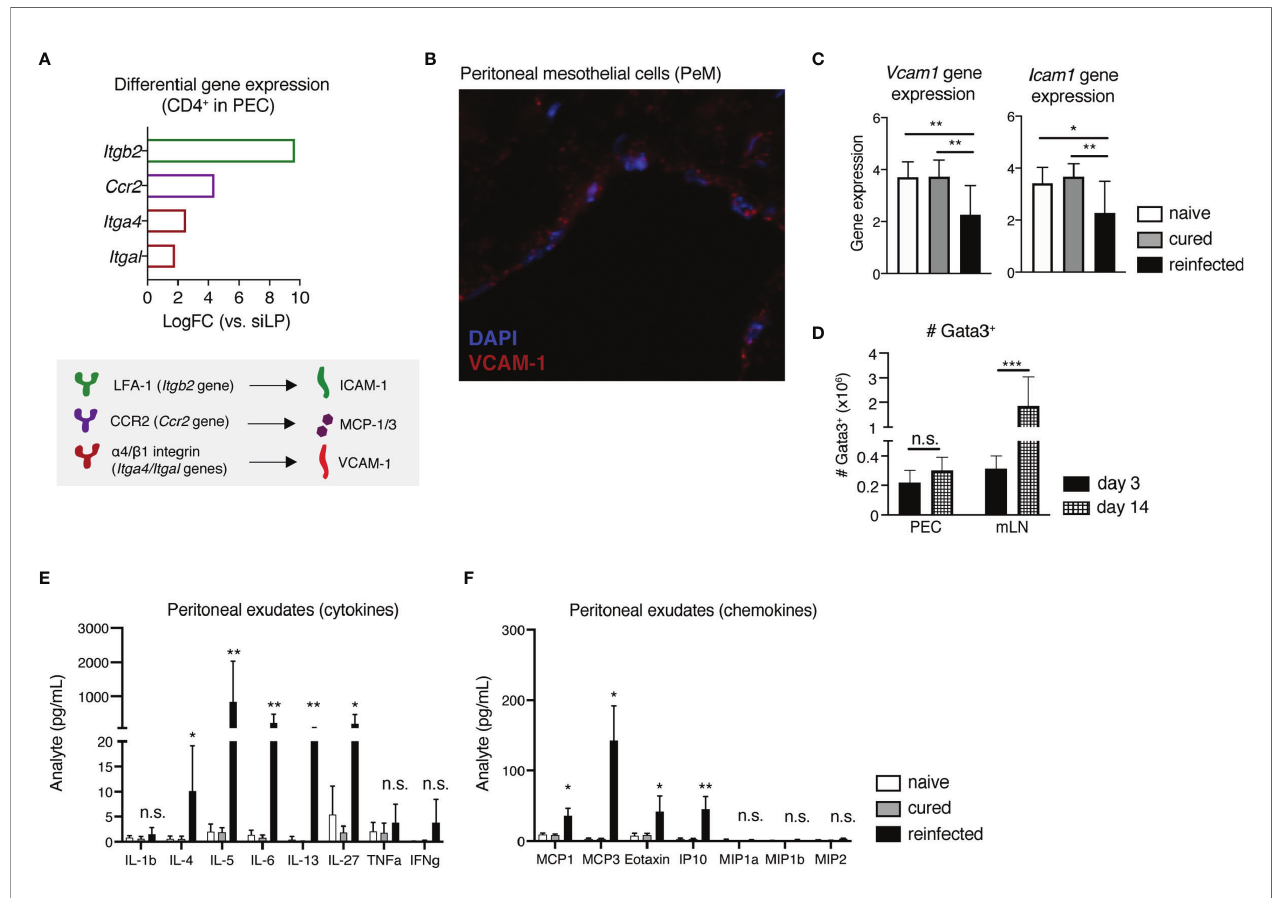
FIGURE 4 | Peritoneal mesothelial cells (PeM) express several cell adhesion markers consistent with the in fl ux of immune cells during early recall responses to H. polygyrus into the peritoneum. (A) Differential gene expression levels of Itgb2, Ccr2, Itga4 and Itgal in sorted CD4 + T cells from the PEC in comparison with siLP-sorted cells, as quanti fi ed via scRNAseq (top) and a graphical legend of cell adhesion marker-ligand binding pairs (bottom). (B) Immuno fl uorescence staining of a peritoneal membrane snip from a naïve C57BL/6 mouse. DAPI nuclear staining is shown in blue and VCAM-1 staining in red. (C) Relative gene expression of Vcam1 and Icam1 in peritoneal membrane snips from naïve, cured and reinfected mice, against GAPDH as a housekeeping gene. (D) Absolute cell numbers of Gata3 + CD4 + CD44 + CD62-L - Foxp3 - Th2 cells in the PEC and mLN of H. polygyrus -reinfected mice at 3 and 14 days post-challenge infection. Quanti fi cation of secreted (E) cytokines and (F) chemokines in peritoneal exudates from naïve, cured and reinfected mice. The data are pooled from two to three independent experiments with n = 2-4 mice per group. Statistical analysis was done using one-way ANOVA combined with Tukey ’ s multiple comparison test. * p < 0.05, ** p < 0.01, *** p < 0.001. n.s., not signi fi